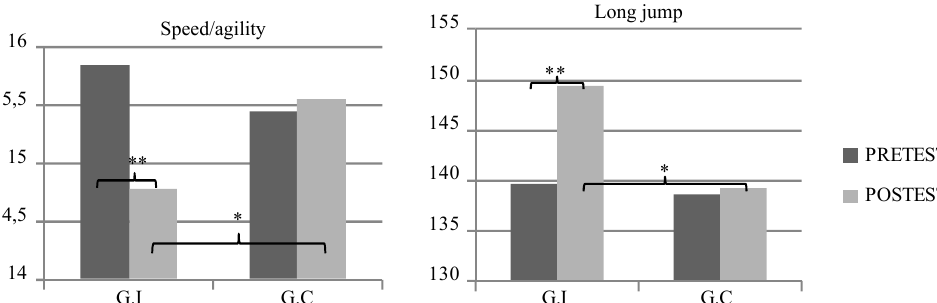
Figure 2. Speed/agility and standing long jump values recorded in the Alpha fitness test battery before and after the control and high-intensity interval training programs (** p<.01; *p<.05)